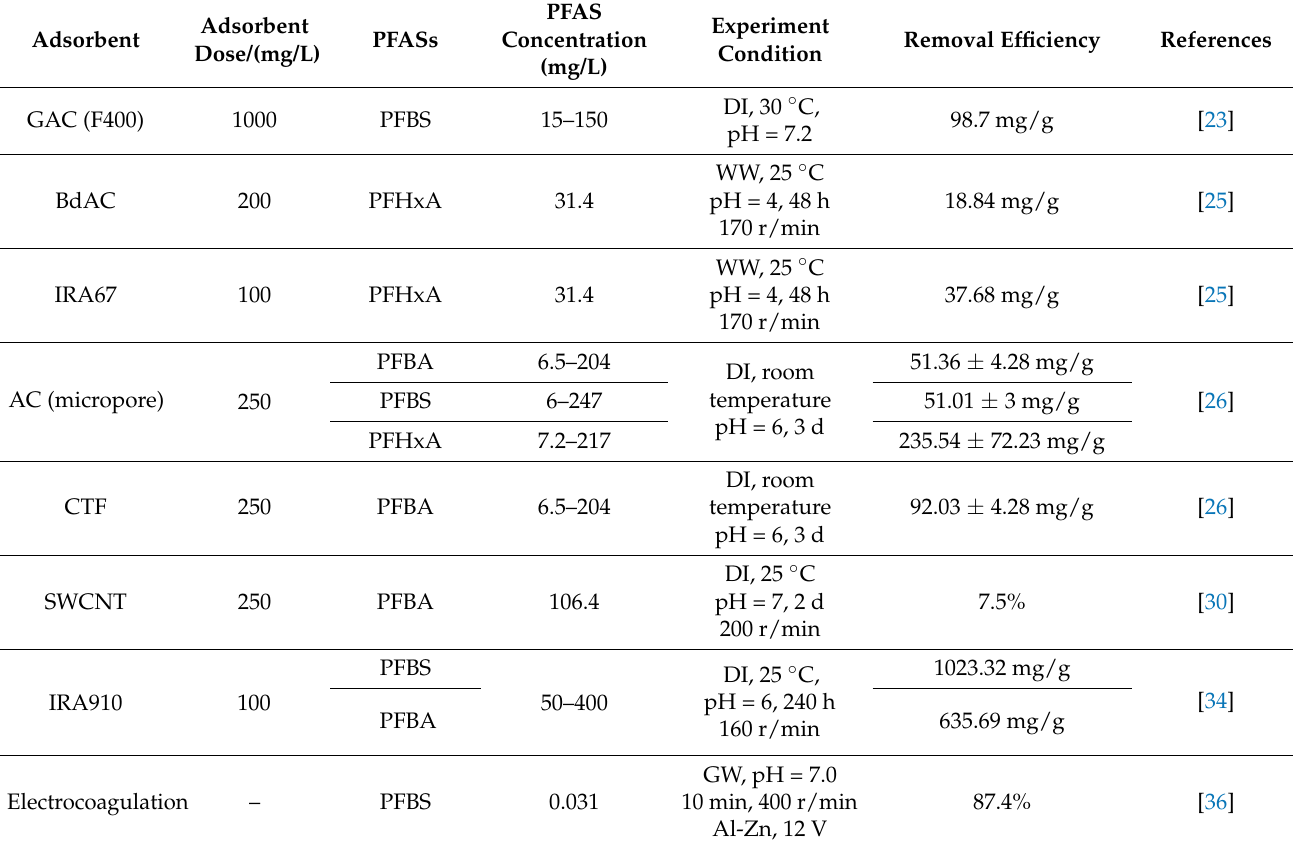
Table 2. Comparisons on adsorption capacities of various adsorbents for short-chain PFASs.